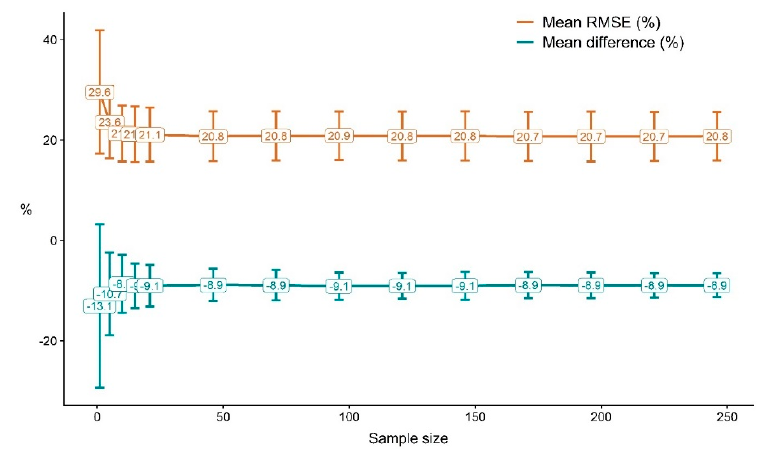
Figure 8. The effect of sample size on relative root mean square error (RMSE; brown) and relative mean difference (blue) of stem-volume estimates. Error bars present the standard deviation around the mean that is also displayed.